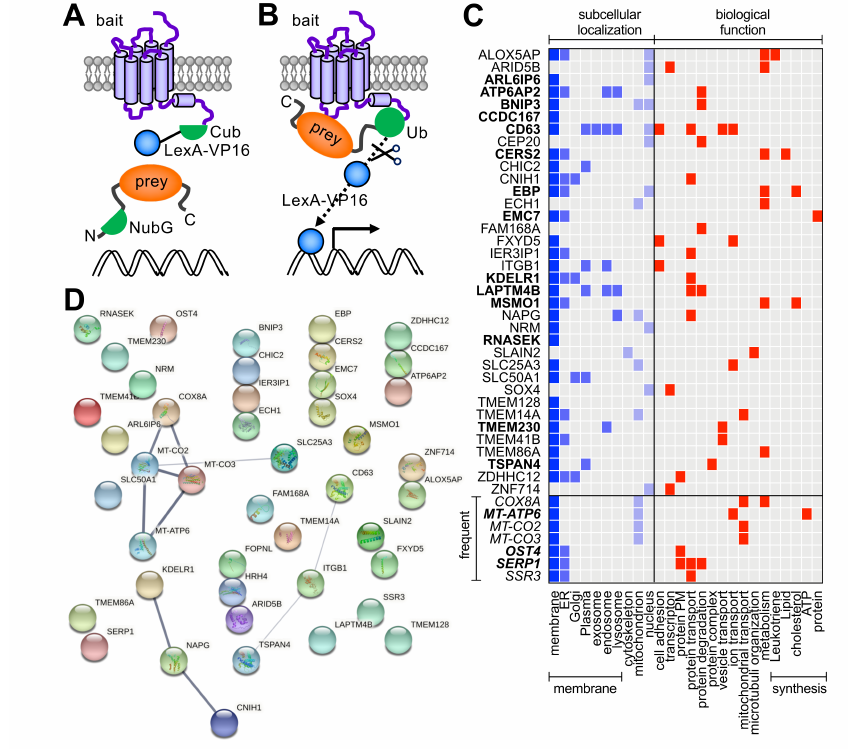
Figure 1. Schematic overview of the split-ubiquitin membrane-based yeast two-hybrid (MYTH) assay. ( A ) Diploid yeast co-expressing the membrane targeted H 4 R-Cub-LexA-VP16 bait and cytosolic (depicted) or membrane-associated N- terminally tagged NubG prey proteins was generated by mating of haploid yeasts expressing the individual bait and prey constructs. ( B ) Interaction of the H 4 R-Cub-LexA-VP16 ‘bait’ with NubG-protein ‘prey’ results in functional reconstitution of a pseudo-ubiquitin, which is subsequently recognized by cytosolic ubiquitin-specific proteases leading to the cleavage of the LexA-VP16 transcriptional activator and the expression of ( HIS3 , ADE2 , LacZ ) reporter genes. ( C ) Subcellular localization and biological function summary of the 43 hits were retrieved from the Uniprot database (https://www.uniprot.org; accessed on 24 June 2021). Gene names are indicated and full description of proteins with Uniprot codes are presented in Supplementary Table S1. Hits in bold have been found to interact with other GPCRs in MYTH screens (see Supplementary Table S1), whereas frequent MYTH screen hits are indicated in italics. ER = endoplasmic reticulum; PM = post-translational modification ( D ) STRING analysis (v.11.0; https://string-db.org; accessed on 25 June 2021) of hits from the MYTH screen of H 4 R (bait) on an unstimulated Jurkat T cell DUALmembrane cDNA library. Known interactions between proteins in the STRING database are indicated by connecting lines. The thickness of the line represents the degree of confidence prediction of the